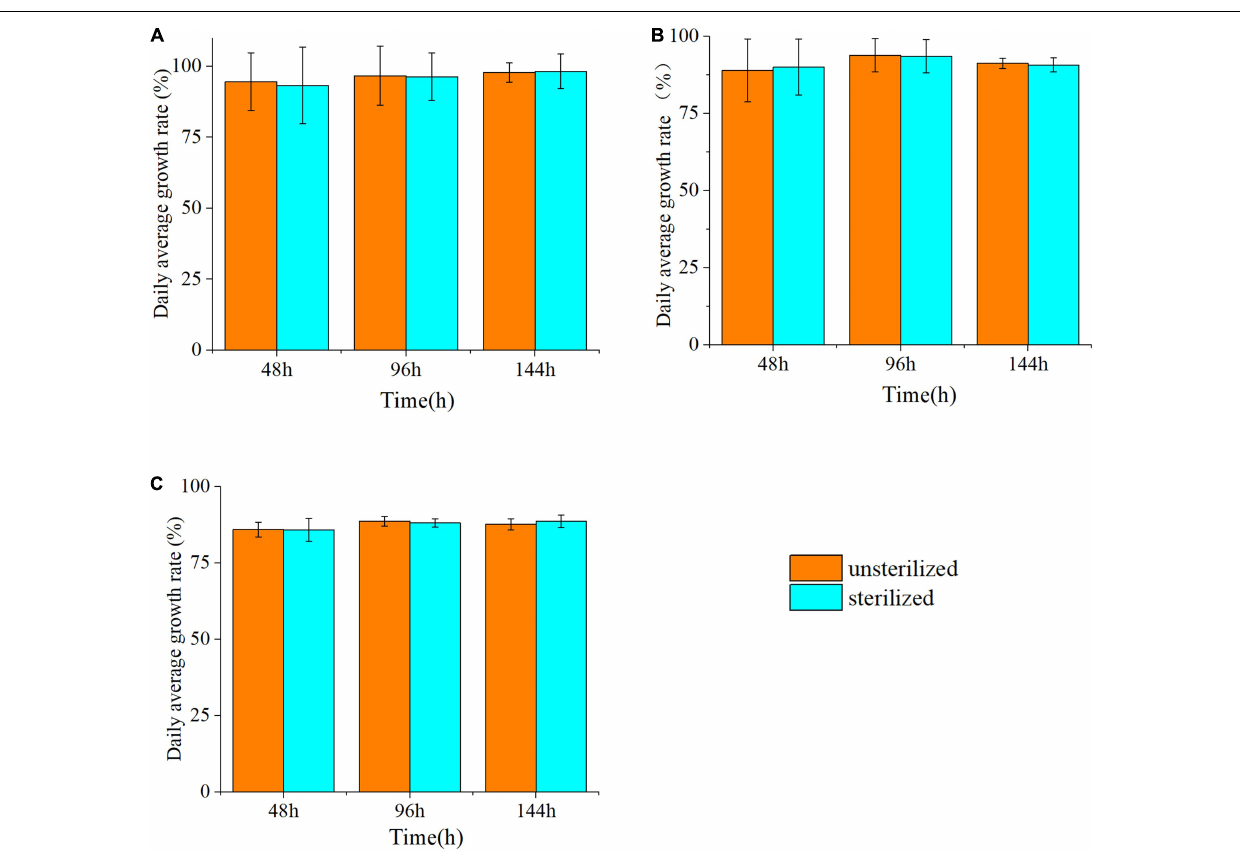
FIGURE 3 | The inhibitory rate (%) of three species of microalgae cultured with unsterilized and sterilized 6 g/L hijiki extract for 48, 96, and 144 h. (A) Prorocentrum donghaiensis ; (B) Skeletonema costatum ; (C) Heterosigma